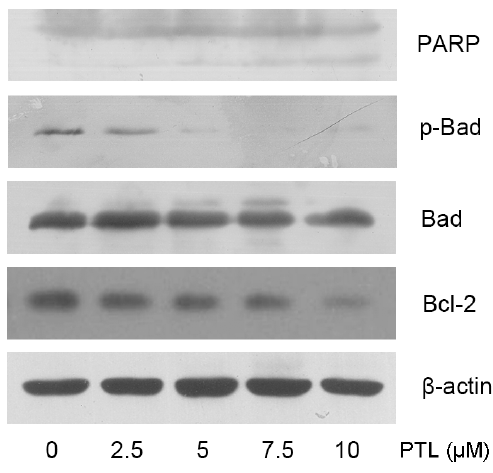
Figure 3. Parthenolide treatment activated PARP and modulated expression of apoptotic genes in 5637 bladder cancer cells.